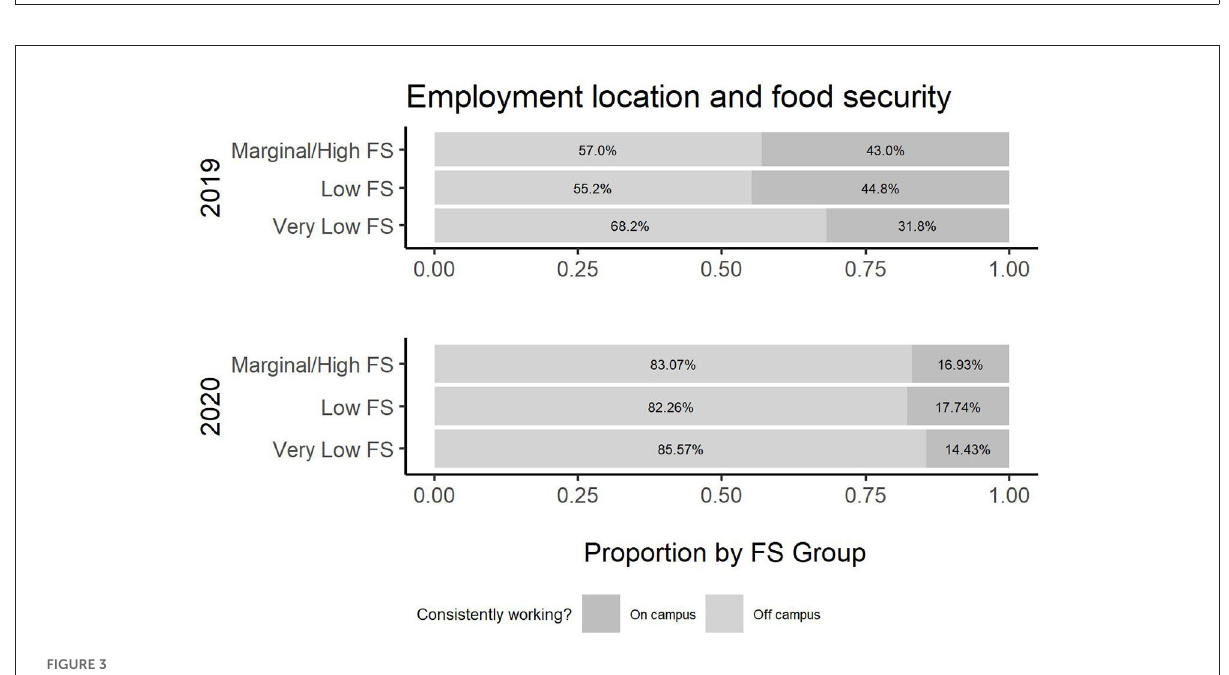
FIGURE3 Employment location and food